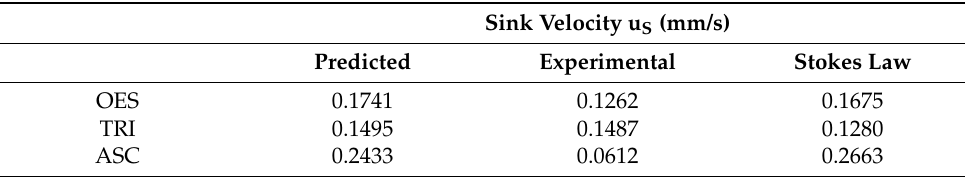
Table 4. Sink velocities: predicted, experimental [20], Stokes law.